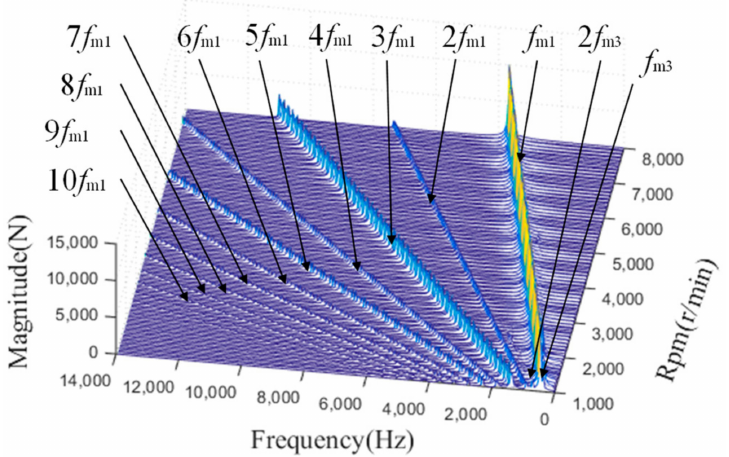
Figure 9. External meshing force of the first gear